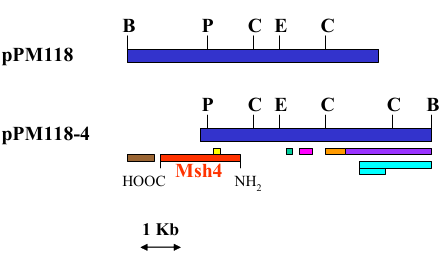
Figure 3. Restriction maps of the inserts of the plasmids pPM118 and pPM118-4, and the location of the MSH4 gene. Restriction maps of the two chromosomal inserts are shown with their corresponding overlapping region. B: Bam HI, C: Cla I, E: Eco RI, P: Pst I. Inserts originated from chromosome VI and the coordinates for the entire region cloned on pPM118 and pPM118-4 extends from 133748 to 141542 bases. Map of chromosomal features from SGD: VTC2 (brown), ARS605 (yellow), Msh4 (red), tRNA-Asn (green), Ty1LTR (pink), Ty2LTR (orange), Ty2 (purple), TyAGag (aqua), TyB